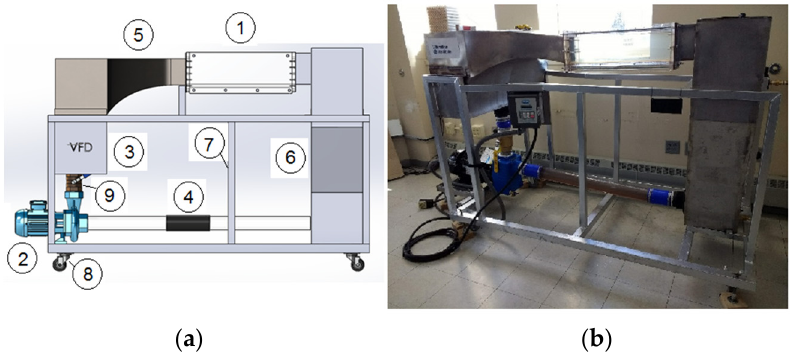
Figure 2. Left panel ( a ) shows the drawing of the water tank and its major components; 1. observation chamber, 2. centrifugal pump, 3. variable frequency drive or pump controller, 4. return pipe to the pump, 5. inlet manifold into the observation chamber, 6. holding tank, 7. structural frame, 8. wheels, and 9. ball valve. On the right, panel ( b ) shows the final product of the water tank supported by frames and wheels.